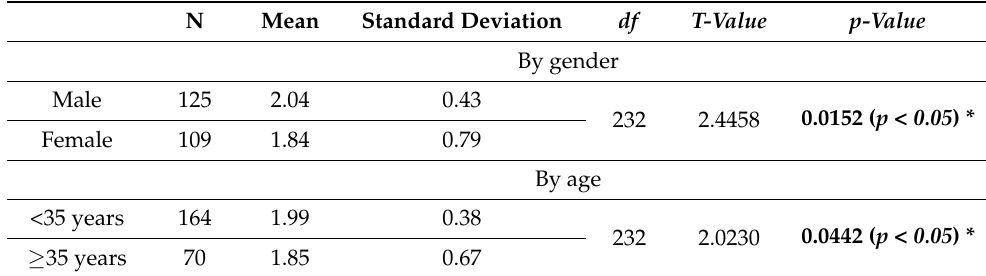
Table 5. Difference in opinions among participants groups in relation to eHealth adoption in future. N